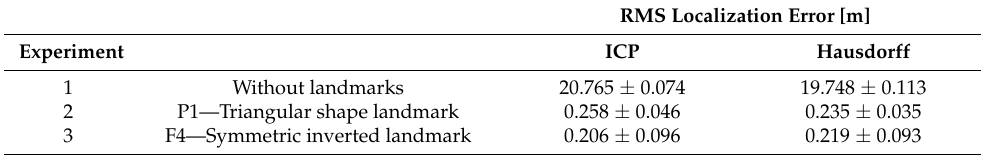
Table 3. RMS localization error using the optimized landmarks during experimental